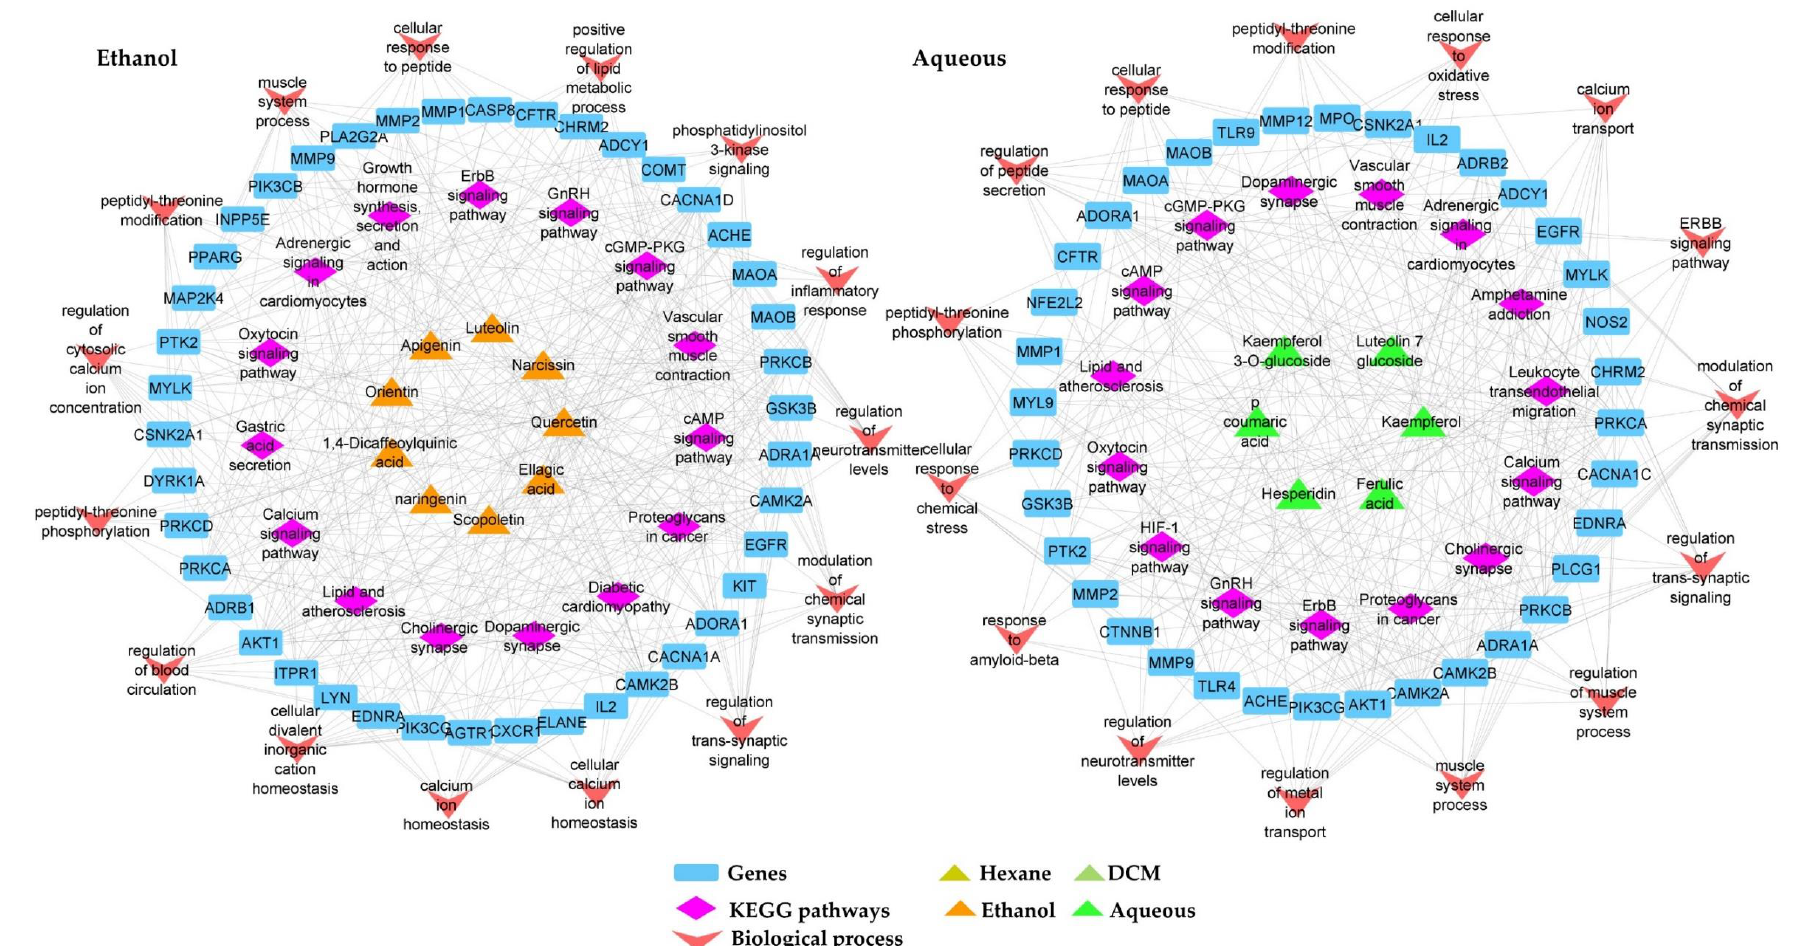
Figure 2. Bioactive chemical network interaction analysis by tool Cytoscape 3.8.0. ( A ) Bioactive compound – target gene network; ( B ) GO biological process and KEGG pathway network of bioactive chemicals and target genes.